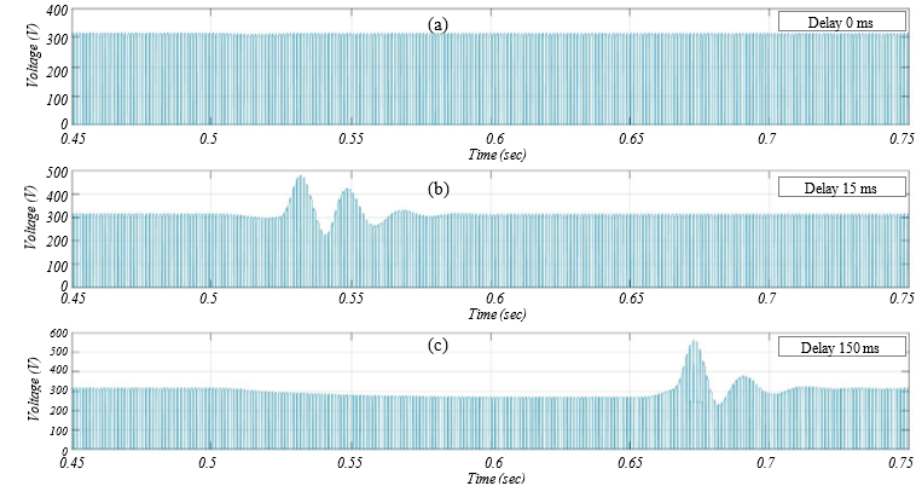
Figure 9. Impact of delay on the boost converter switch S bo , C T = 4800 µ F and I m = 7.1 A: ( a ) during grid-tie, ( b ) for a delay of 15 ms, and ( c ) for a delay of 150 ms. Table 4. Wireless Communication Technologies’ delays.